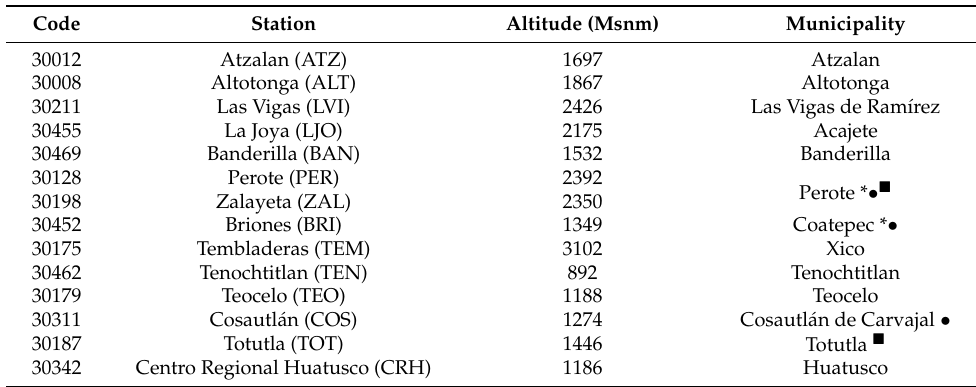
Table A1. Weather station’s names and the municipalities of the state of Veracruz, Mexico, where they are located